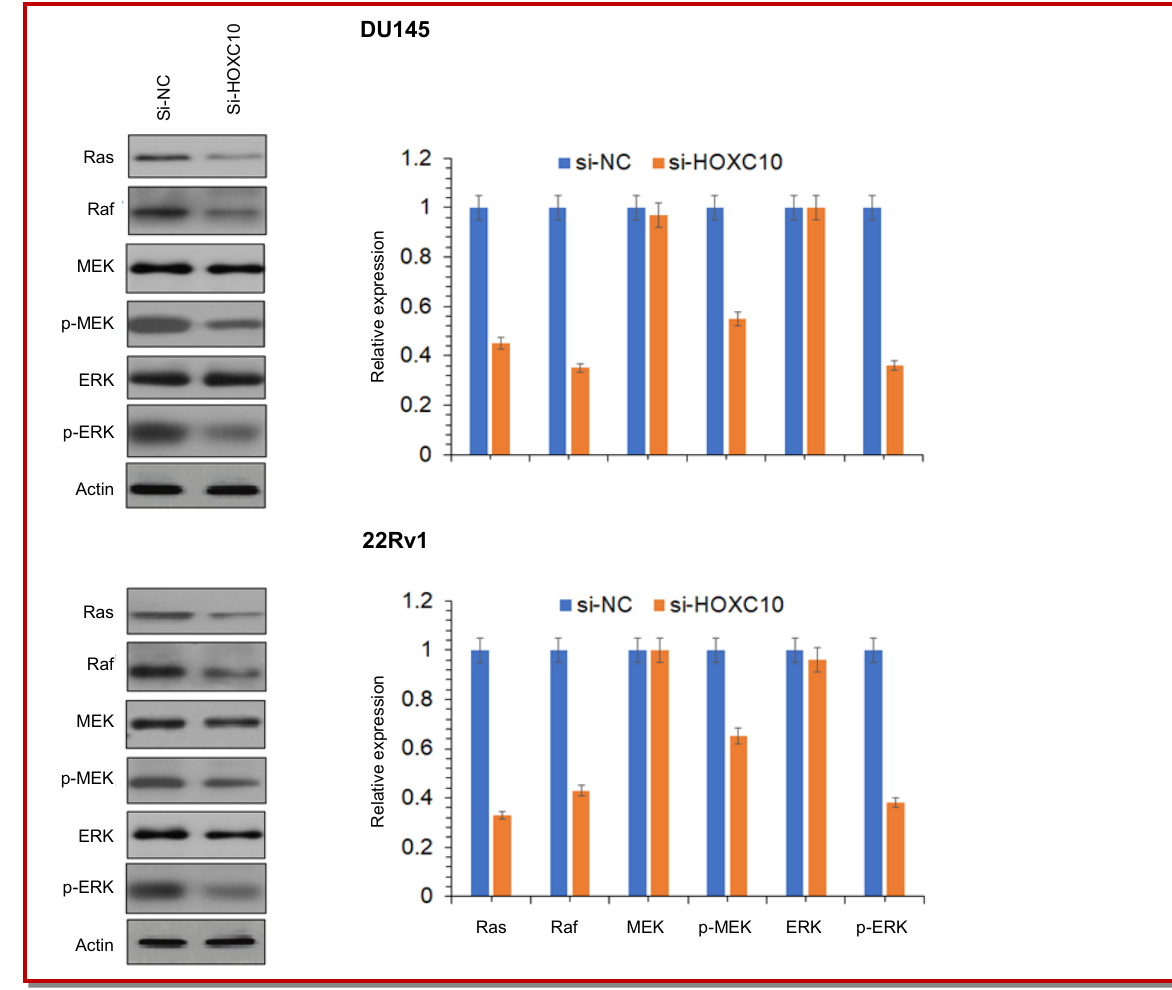
Figure 6: Silencing of HOXC10 gene inhibited the Ras/Raf/MEK/ERK signaling pathway . (A) Western blotting of Ras, Raf, MEK, p-MEK, ERK and p-ERK proteins from DU145 prostate cancer cell lines transfected with si-NC or si-HOXC10 (B) Western blotting of Ras, Raf, MEK, p-MEK, ERK and p-ERK proteins of 22Rv1 prostate cancer cell lines transfected with si-NC or si-HOXC10. The experiments were performed in triplicates and expressed as mean ± SD